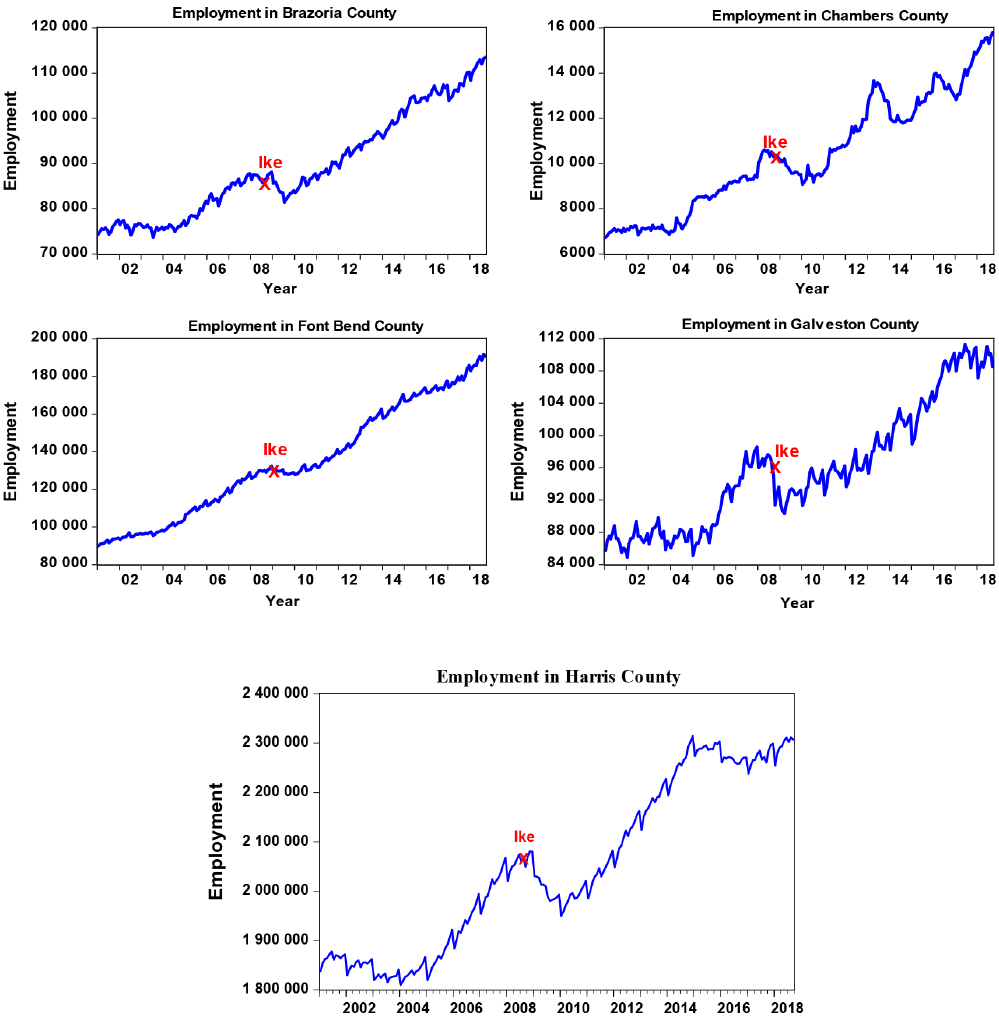
Figure 3. Monthly employment time series in five counties within Houston MSA before and after Hurricane Ike.